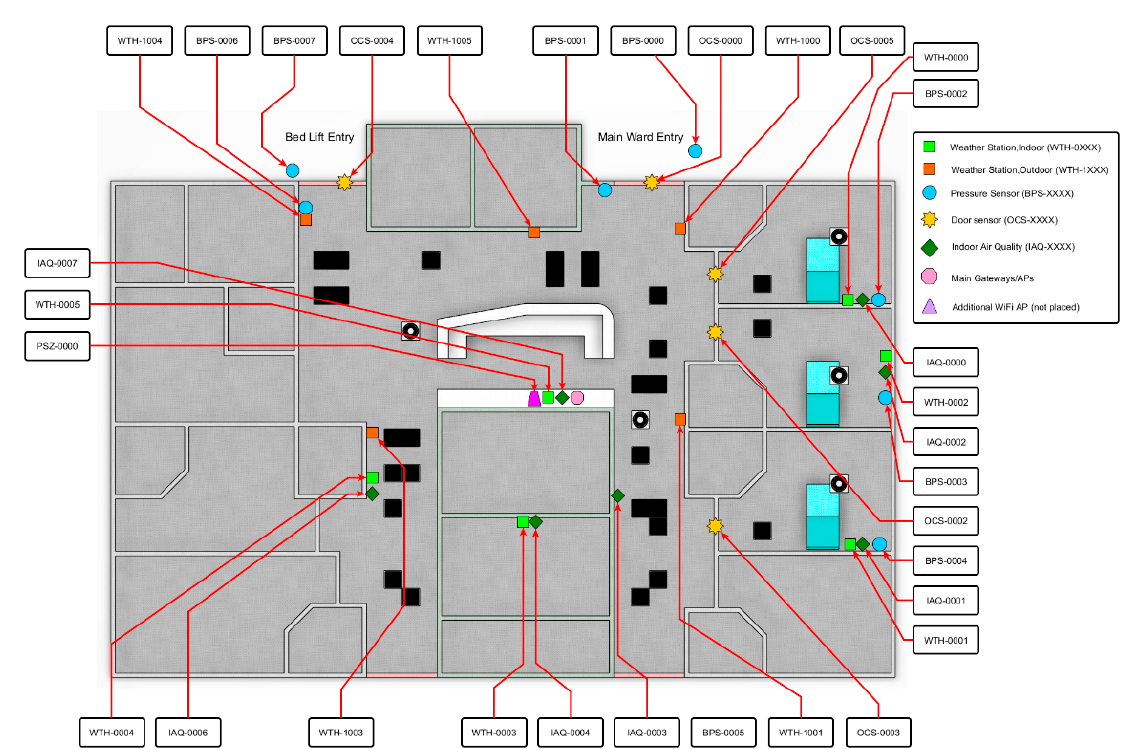
Figure A8. Sensor placement for the hospital ward.